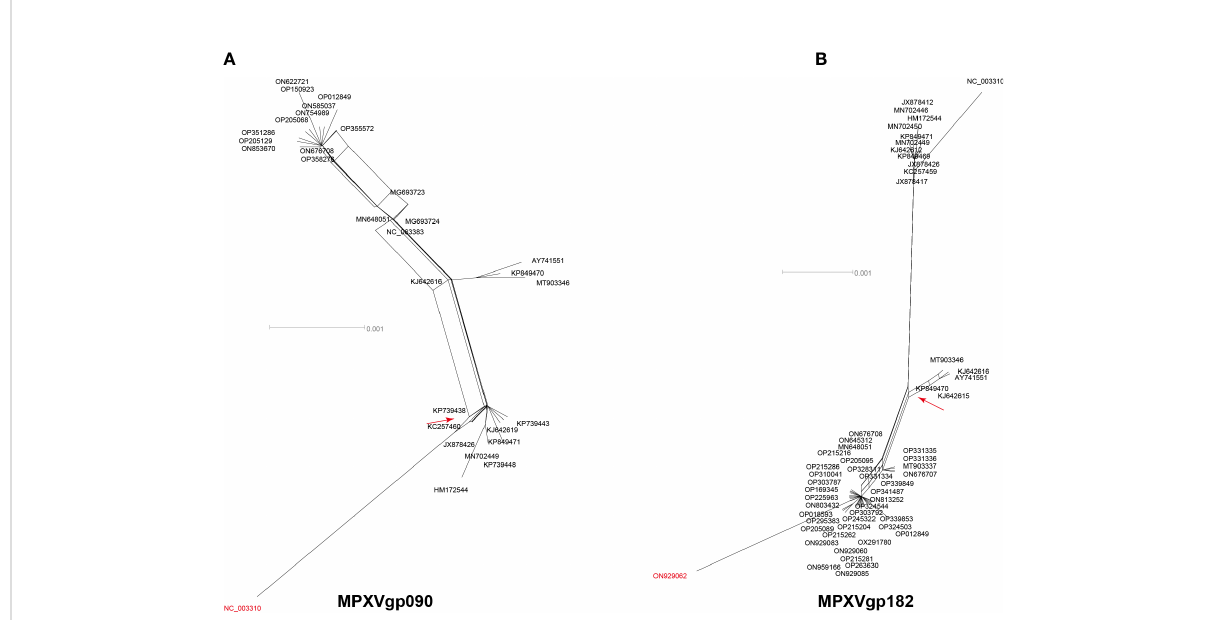
FIGURE 1 Neighbor-net phylogenetic network shows the relationship among the MPXVgp090 (A) and MPXVgp182 (B) alleles. The relation between and within alleles is illustrated by splits, representing simultaneously both grouping in the data and evolutionary distances between taxa, highlighting potential con fl icting signals or alternative phylogenetic histories (recombination) in the gene molecular evolution. Allele names are shown as their representative MPXV isolate names, shown as GenBank accession numbers, and those that are marked in red indicate that they are recombinants. The network ’ s internal nodes indicate hypothetical ancestral alleles, while the edges conform to reticulate events like recombination. The red arrow points to a representative reticulate event. Recombination events that were identi fi ed by three or more methods were selected and numbered. The parents ’ names of the recombinant were indicated according to the RDP5 analysis (see Table